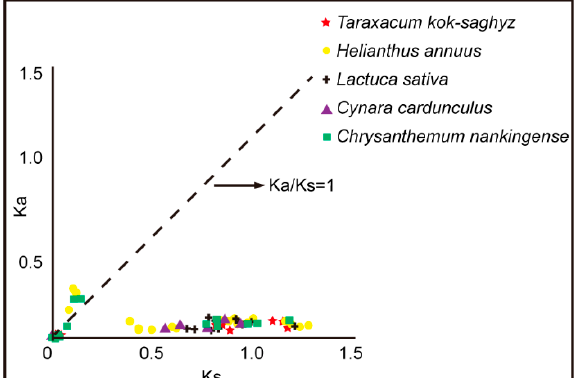
Figure 2. The Ka and Ks values of duplicated gene pairs in Asteraceae . The Ka and Ks values were calculated using Dnasp 4.0. Different colored shapes represent the Ka/Ks ratio of duplicated gene pairs from corresponding species.